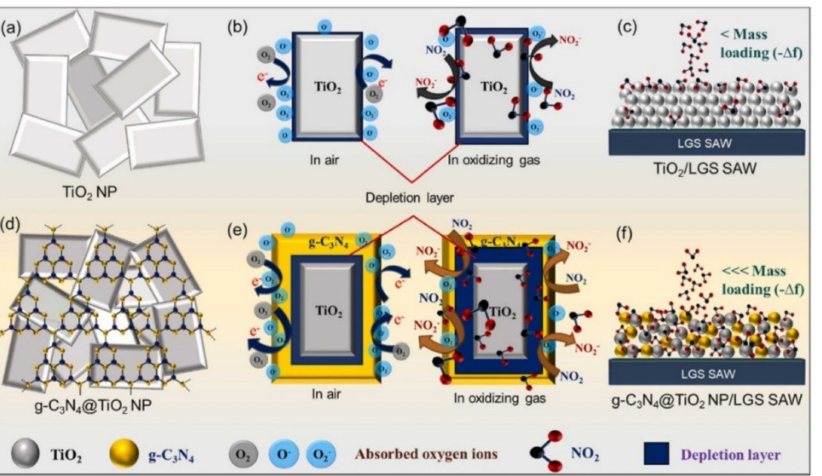
Figure 6. Schematic illustrations of the plausible NO 2 gas sensing mechanism of ( a – c ) pristine TiO 2 NP and ( d – f ) g − C 3 N 4 @TiO 2 NP hybrid nanocomposite heterostructures at RT. Reprinted with permission from Ref. [13]. Copyright 2022 American Chemical